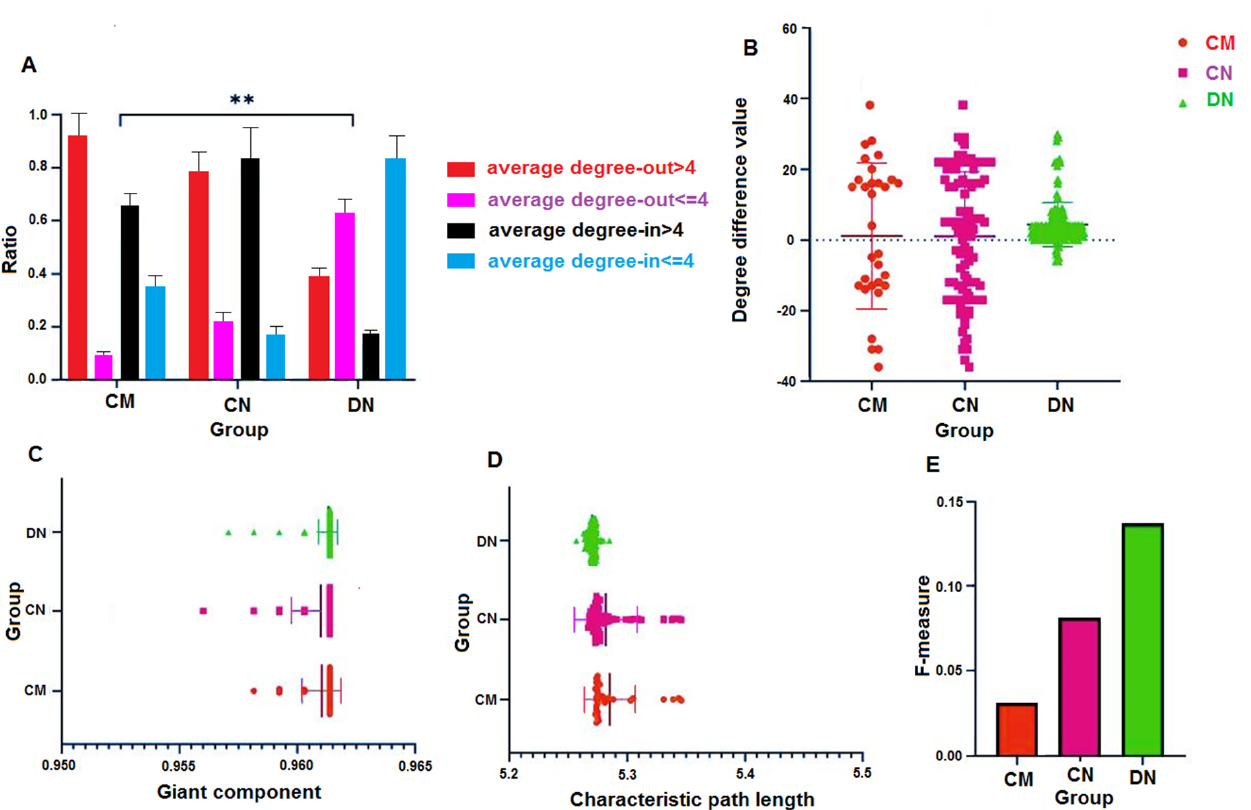
Figure 8. GEO data validation results: ( A ) the distribution probability of 4 levels of the HNS; ( B ) compare the degree difference values in CM (core module), CN (core nodes), and DN (driver nodes); ( C ) comparison of the changes in the giant component after the nodes in CM, CN, and DN are deleted; ( D ) comparison of the changes in the characteristic path length after the nodes in CM, CN, and DN are deleted; ( E ) the F-measure of genes overlapping with CM, CN, and DN in the CTD list. All data are represented as the mean ± SEM. **p < 0.05.